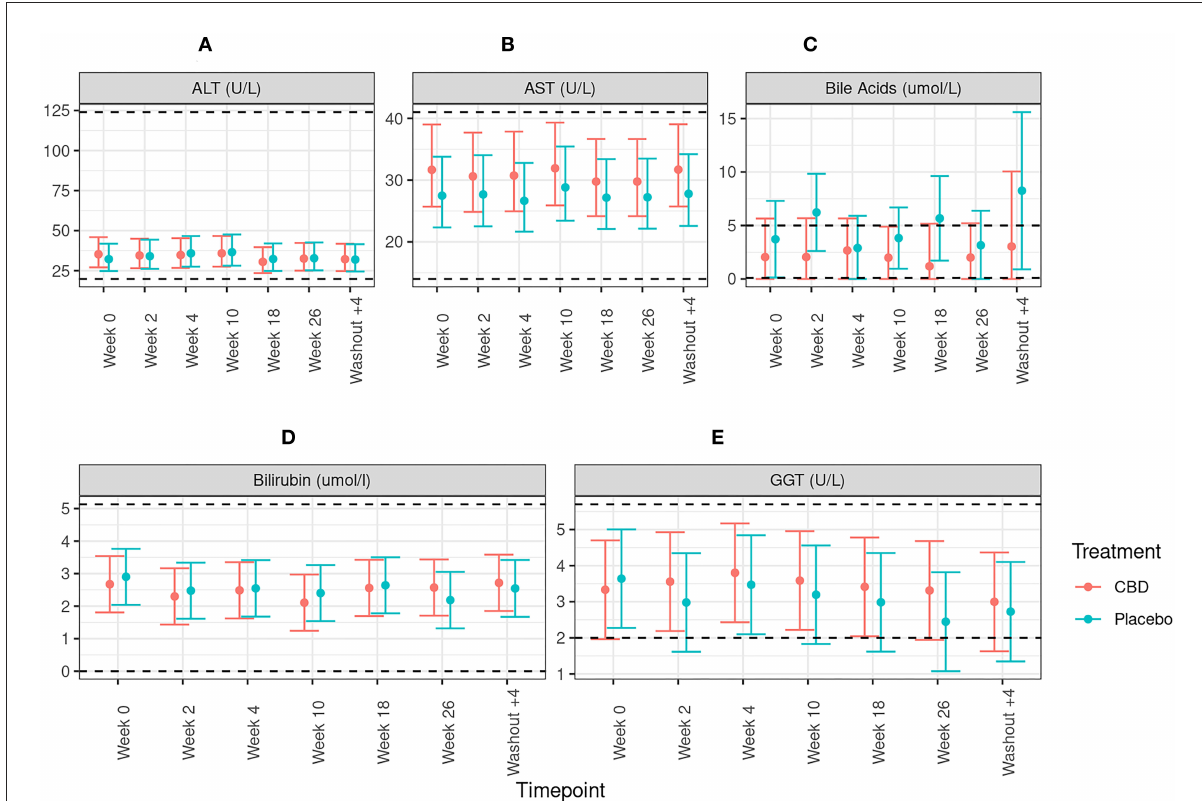
FIGURE3 Means and 95% confidence intervals of (A) alanine transaminase activity (ALT; U/L), (B) aspartate aminotransferase activity (AST; U/L), (C) Bile acid concentration (umol/L), (D) bilirubin concentration (umol/L) and (E) gamma-glutamyl transferase activity (GGT; U/L) in dogs dosed with CBD (red) and placebo- (blue). Week 0 depicts the baseline measure before daily oral dosing of CBD/placebo. Dotted line depicts upper and lower reference ranges as specified by IDEXX Laboratories.